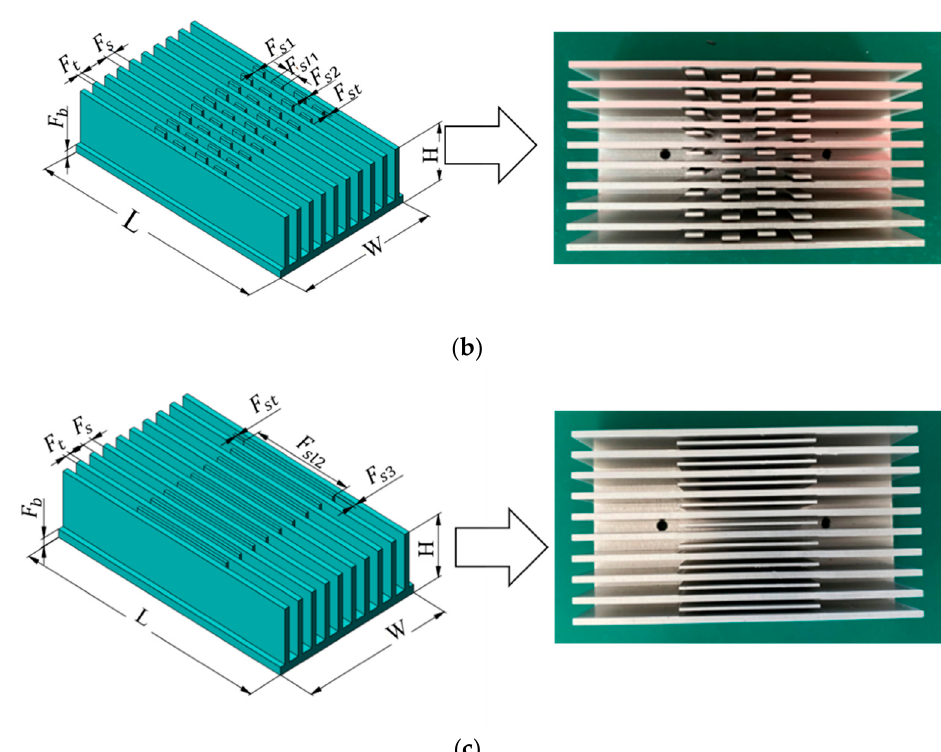
Figure 2. Dimensions and physical drawings of three types of finned heat sinks; ( a ) plate finned heat sink; ( b ) sub-offset strip plate finned heat sink; ( c ) sub-plate finned heat sink.